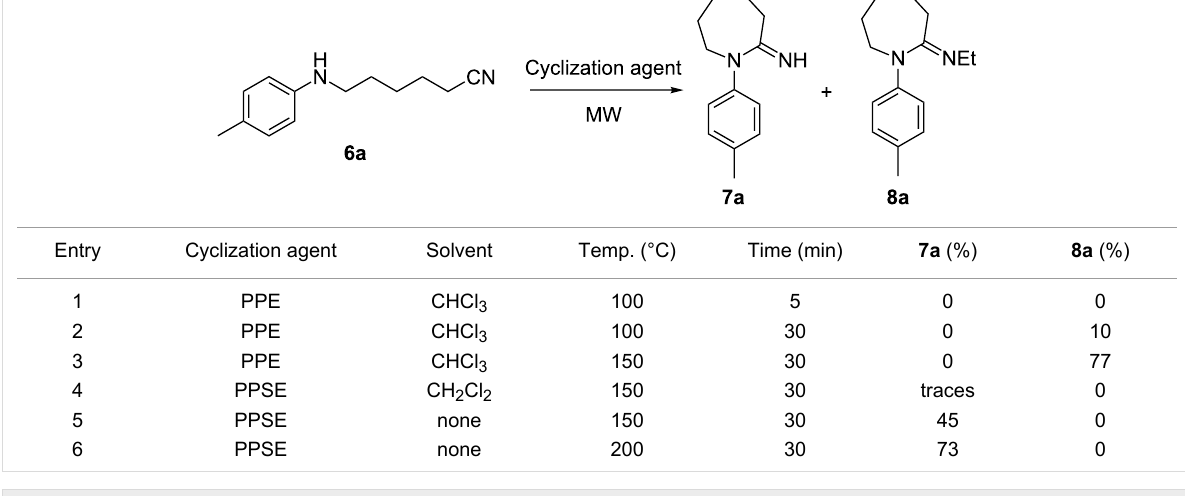
Table 5: Synthesis of 1-aryl-2-iminoazepanes 7